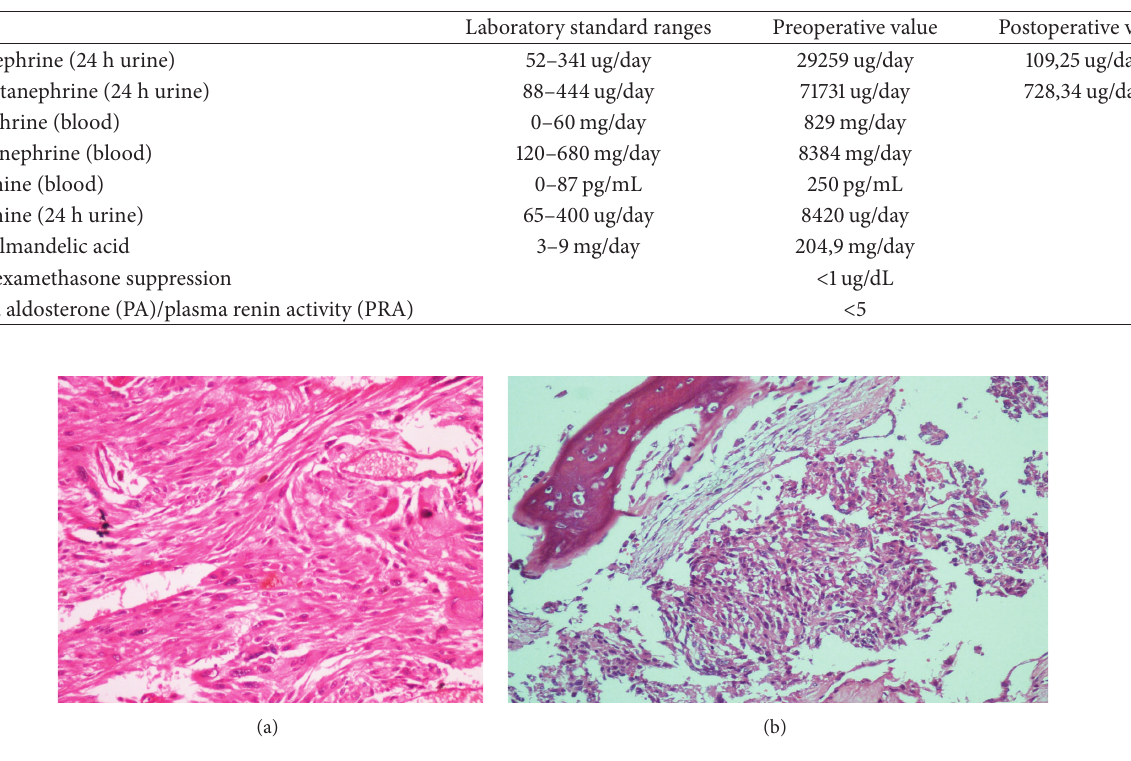
Figure 6: Pathological view. (a) Pleomorphic spindle-shaped tumor cells with the lost organoid pattern in surrenal gland histology (H&E × 400). (b) Tumoral cells infiltrating the bone with similar morphology of adrenal mass in rib histology (H&E ×